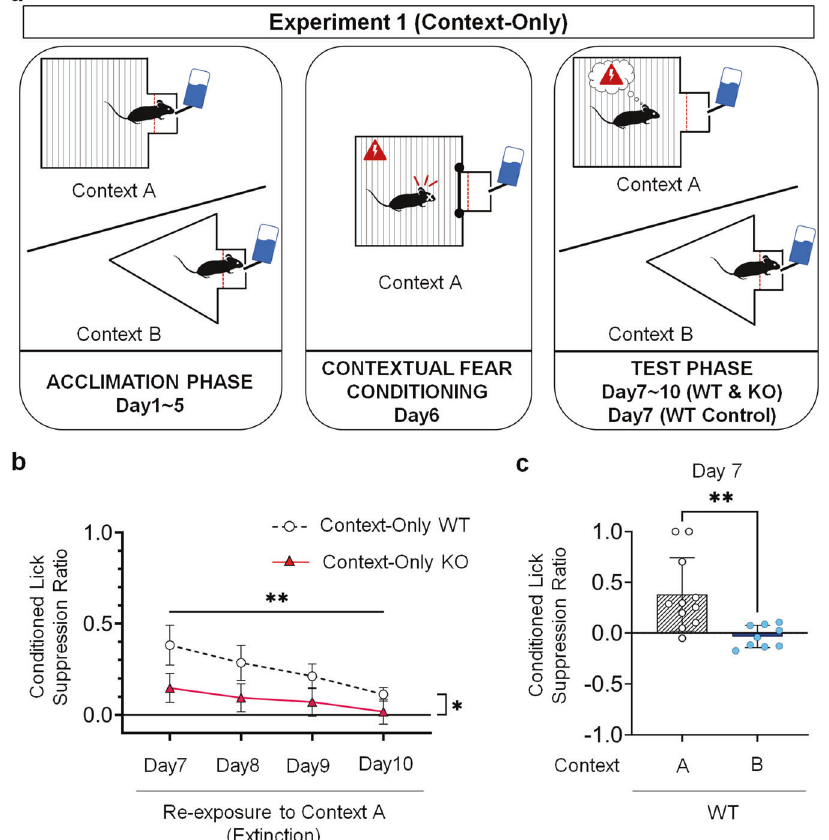
Fig. 2 Contextual conditioned fear responses. a Schematic drawing of each of the three phases of the contextual condition lick suppression task. b Contextual conditioned lick suppression performance in WT mice (Context-Only WT Group; N = 11) compared to KO mice (Context- Only KO Group; N = 11) tested from Day 7 to Day 10 in the same context (Context A) where they received the fear conditioning session. Two- way analysis of variance (ANOVA) for repeated measures, followed by Bonferroni post-hoc test. Data are expressed as means and error bars represent ±SEM. Asterisks indicate P -values (* P < 0.05, ** P < 0.01). c Conditioned lick suppression performance in WT mice tested at Day 7 in the same context as the conditioning context (Context-Only WT Group; N = 11) compared to WT mice tested at Day 7 in a different context (Context B) than the conditioning context (Context-Only Control WT Group; N = 9). Two-tailed t-test for independent samples with a Bonferroni correction. Data are expressed as means and error bars represent ±SEM. Asterisks indicate P -values (** P < determined by a two-tailed t-test for independent samples with a Bonferroni correction ( t (12.162) = 3.601, p = 0.004) (Fig. 2c). These results con fi rmed that the conditioned fear responses observed in the Context-Only WT Group were a consequence of the Context B → Foot shock memory formed during the contextual fear conditioning phase and retrieved during the test phase. These data validate the use of contextual conditioned lick suppression as a measure of fear responses to a context previously paired with an aversive event. Experiment 2: 5-HT 2C receptor KO mice display reduced cued conditioned fear responses compared to WT mice We fi rst compared the cued conditioned lick suppression ratio of mice during the fi rst tone delivery at Day 7 (i.e., Extinction Day 1) and found a lower suppression ratio in the Cue-Only KO Group ( N = 8, Mean = 0.7968, SD = 0.0674) compared to the Cue-Only WT group ( N = 9, Mean = 0.9706, SD = 0.0470), an effect that was statistically signi fi cant as determined by a two-tailed t- test for independent samples with a Bonferroni correction ( t (15) = 6.228, p < 0.001) (Fig. 3b). These data indicate that KO mice manifest reduced cued fear responses compared to WT mice during the fi rst tone presentation. As a validation of the contextual cued lick suppression task used here, we ran an additional group of WT mice (Cue-Only Control